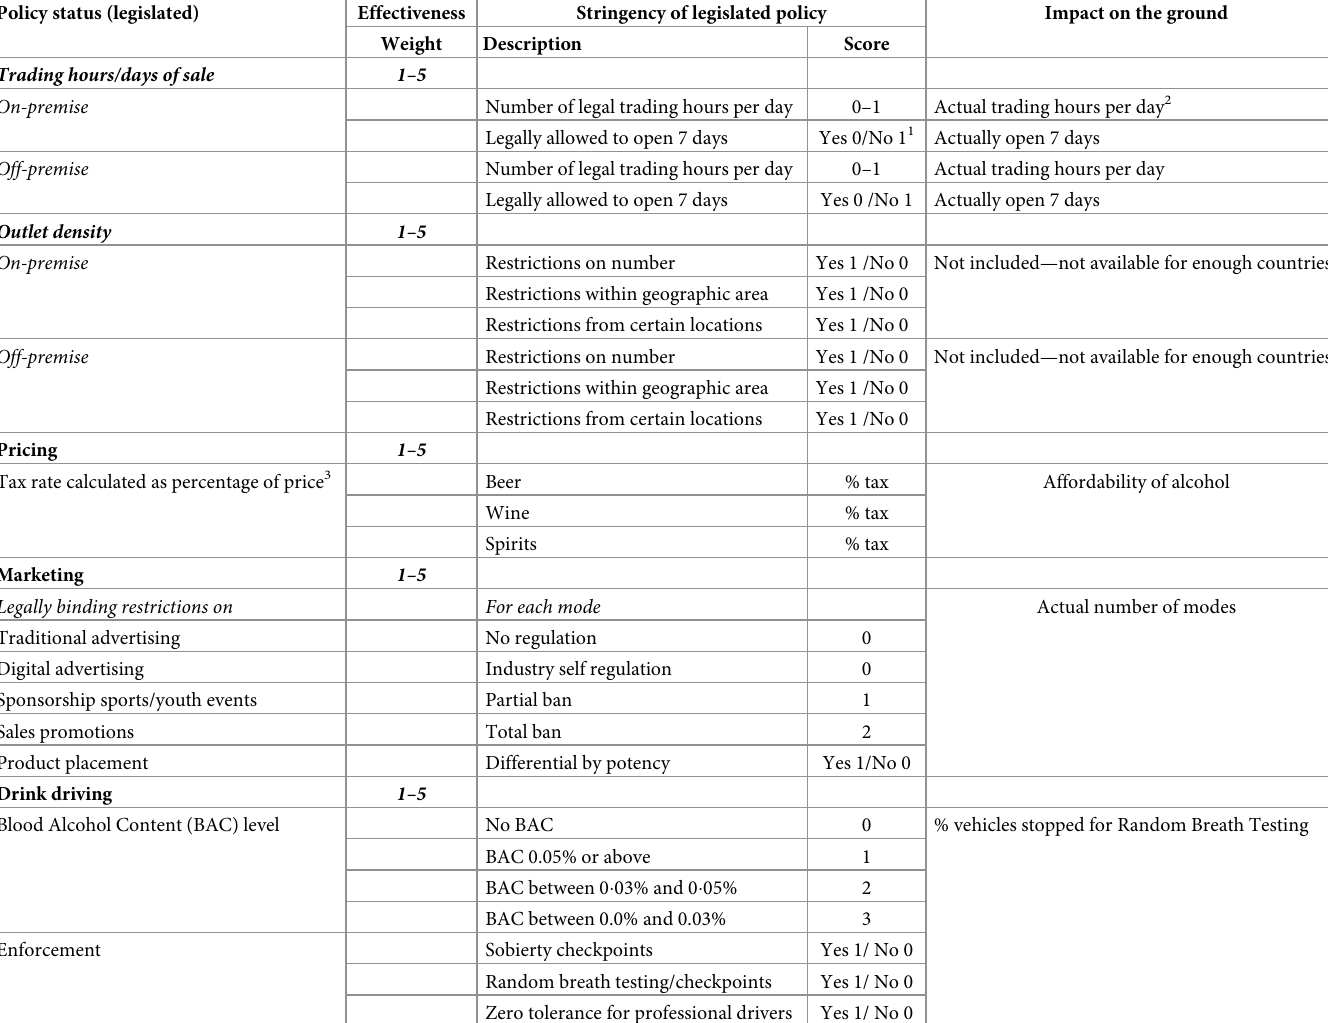
Table 1. Measures and weighting parameters used for the IAC policy